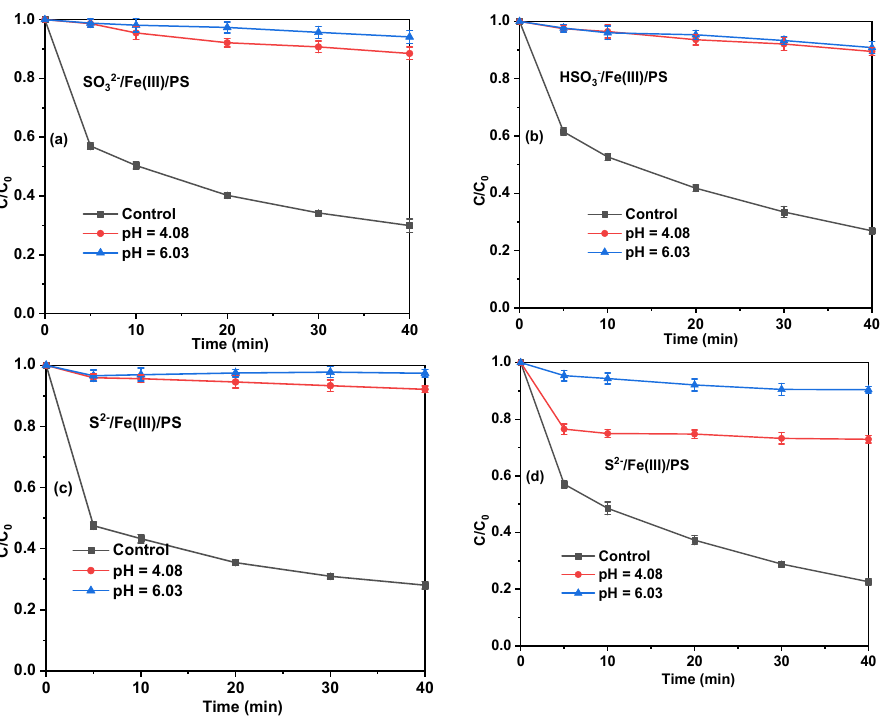
Figure 4. Effect of the initial pH on the removal efficiency of BPA in the SO 32− /Fe(III)/PS ( a ); HSO 3− /Fe(III)/PS ( b ); S 2− /Fe(III)/PS ( c ) and HS − /Fe(III)/PS ( d ) system. Reaction conditions: [Fe(III)] = 1.0 mM, [SO 32− ] = [HSO 3− ] = [S 2− ] = [HS − ] = 1.0 mM, [PS] = 4 mM, [BPA] = 10.0 mg/L.